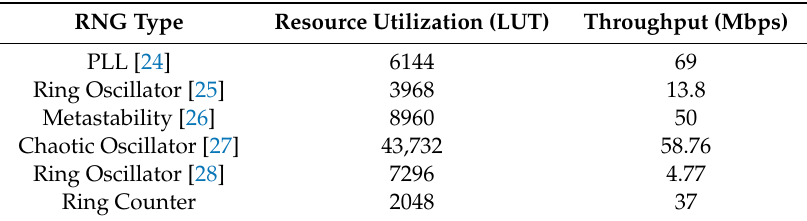
Table 6. Throughput comparison between the TRNG implementation in the Field-Programmable Gate Array